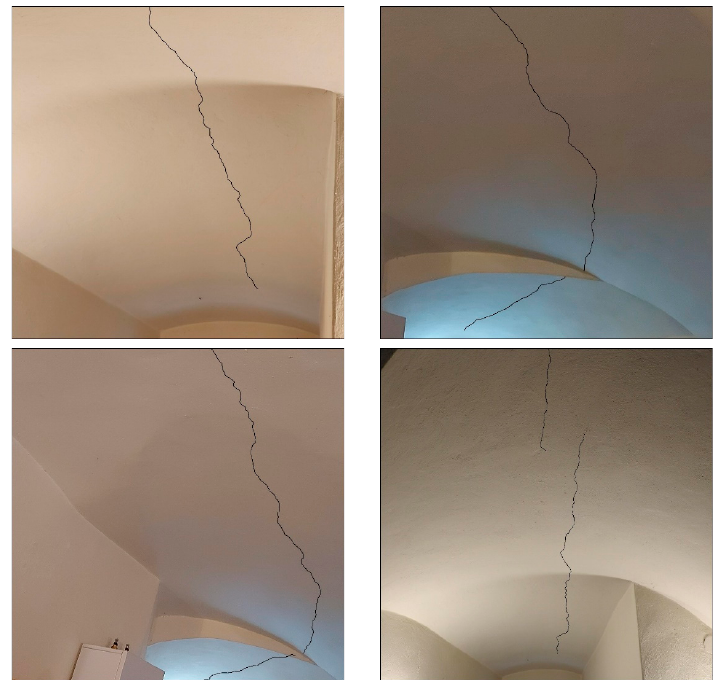
Figure 13. Damage observed on ceiling vault of the west tower at ground floor (damage ID on all four images is 13 in Figure 10a).